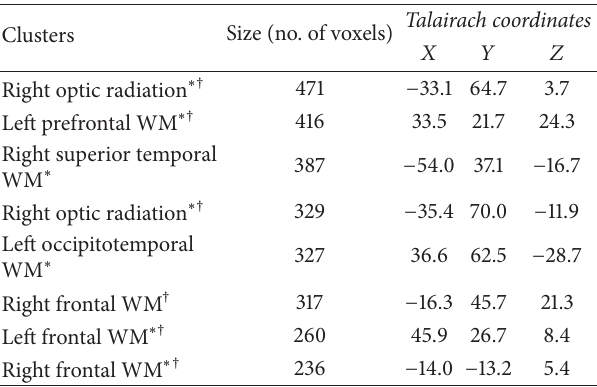
Figure 4: Four largest clusters demonstrating significant asso- ciations between FA and residualized arteriolar diameter among patients with HTN (VANCOVA analysis controlling for age and BMI; minimum cluster size of 100 voxels; 𝑃 < 0.01 ; clusters in deep blue represent positive associations whereas those in orange rep- resent negative associations). Each column shows three orthogonal orientations of the average normalized structural image illustrating a significant cluster with the axes passing through the centroid of the cluster (the Talairach space coordinates for the clusters are listed on Table 5). Table 5: Significant clusters of association between residualized retinal arteriolar diameter and WM FA reduction in HTN ( > 200 voxels in size; 𝑃 < 0.01